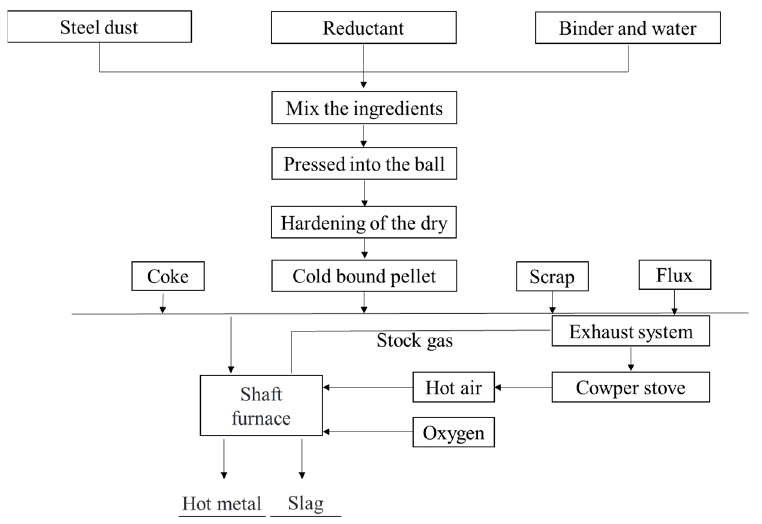
Figure 9. Flow chart of OxyCup process [33,40–42].